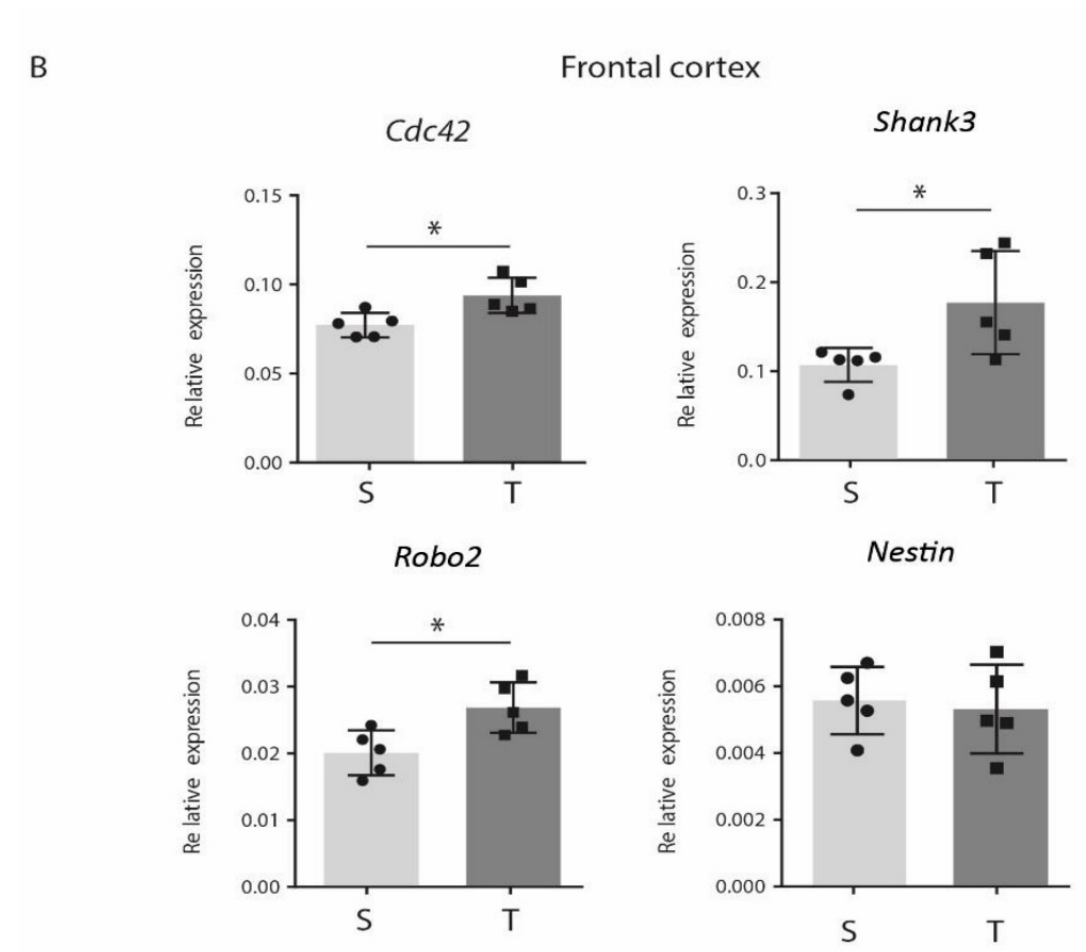
Figure 4. Continuous progressive aerobic exercise (CP AE) modulates gene expression of synaptic-related genes in frontal cortex (FC). Histograms reporting gene expression analysis of Cdc42, Shank3, Robo2, and Nestin analyzed by RT-qPCR on RNA extracted from ( A ) hippocampus and ( B ) FC of the sedentary ( n = 5) and the CP-trained mice ( n = 5). CP protocol upregulates (Cdc42 p = 0.0153; Shank3 p = 0.0417; Robo2 p = 0.0177) these genes with respect to the sedentary animals in FC and not in hippocampus. Nestin is not modulated after CP training. β -actin is used as reference gene. (* p < 0.05). Error bars represent SD. Solid circle: sedentary mice. Solid square: trained mice.